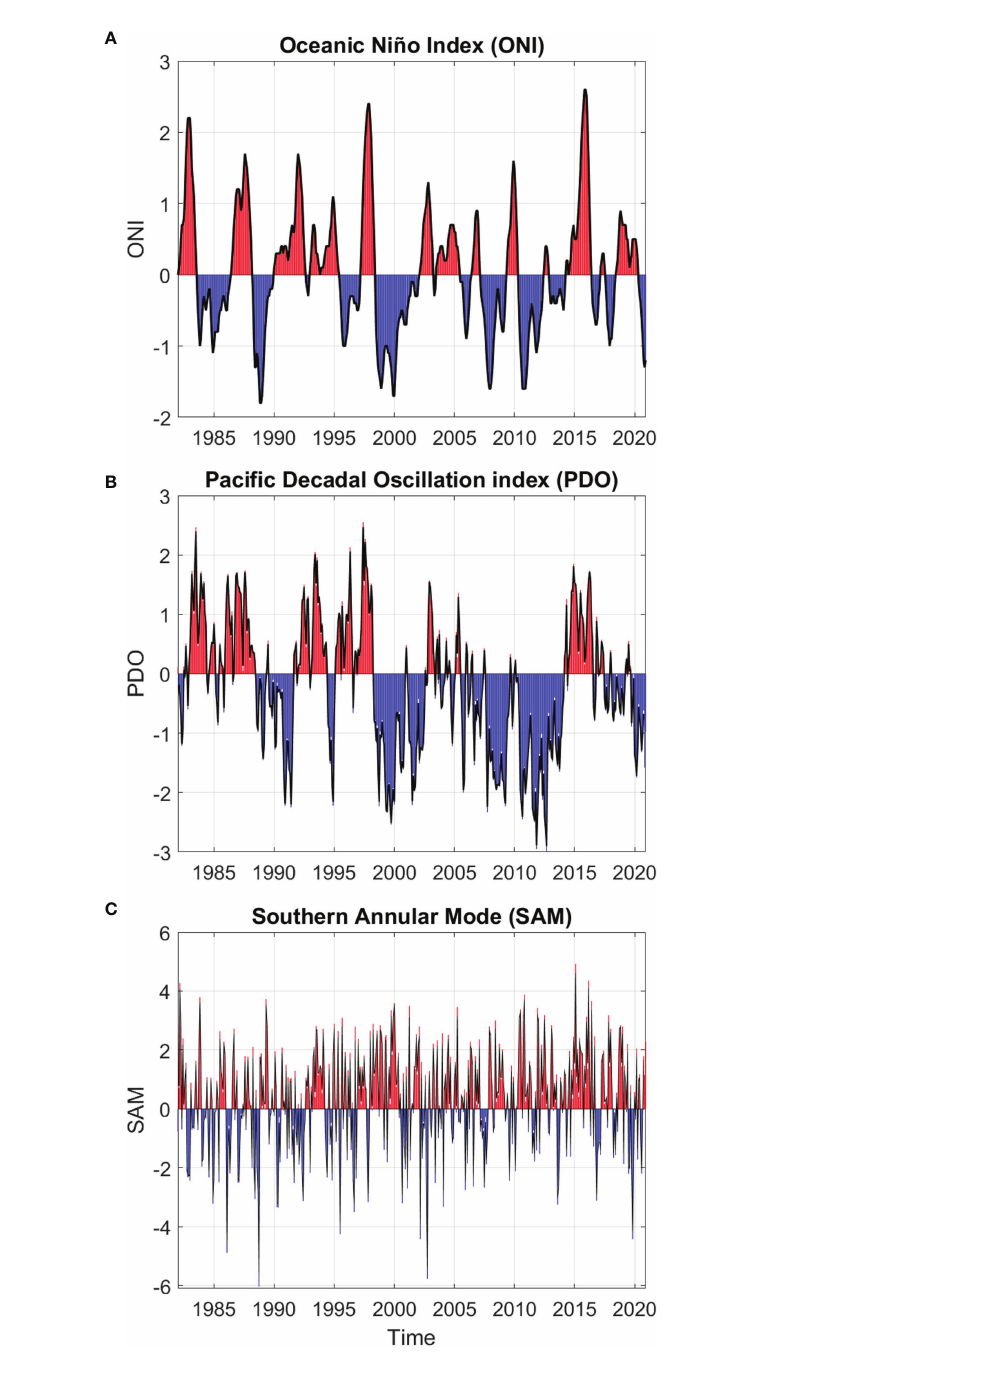
FIGURE 12 | Different remotes forcings expressed by their index. (A) Oceanic Niño Index for ENSO monitoring (ONI), (B) Paci fi c Decadal Oscillation (PDO) index, (C) Southern Annular Mode (SAM) index. Red indicates a positive period and blue a negative period. PDO and SAM index are expressed with a 3-month Gauss fi lter, represented by the black bold line. ONI calculation is already based on a 3-month average. The scale differs according to the